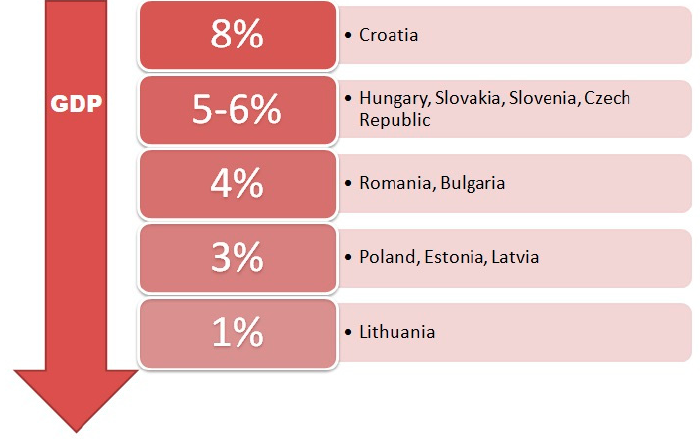
Figure 3. GDP decline due to the pandemic by country [20–23].